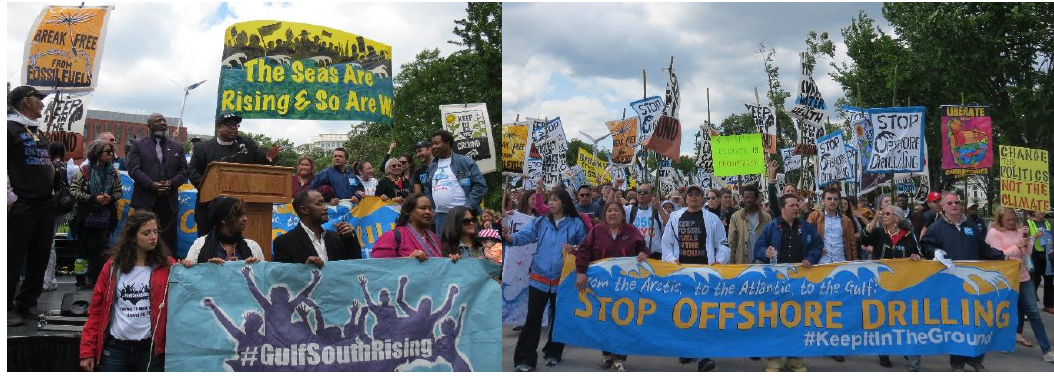
Figure 2. “Break Free” Protests in Washington, DC (Photo credits: Mary Finley-Brook).